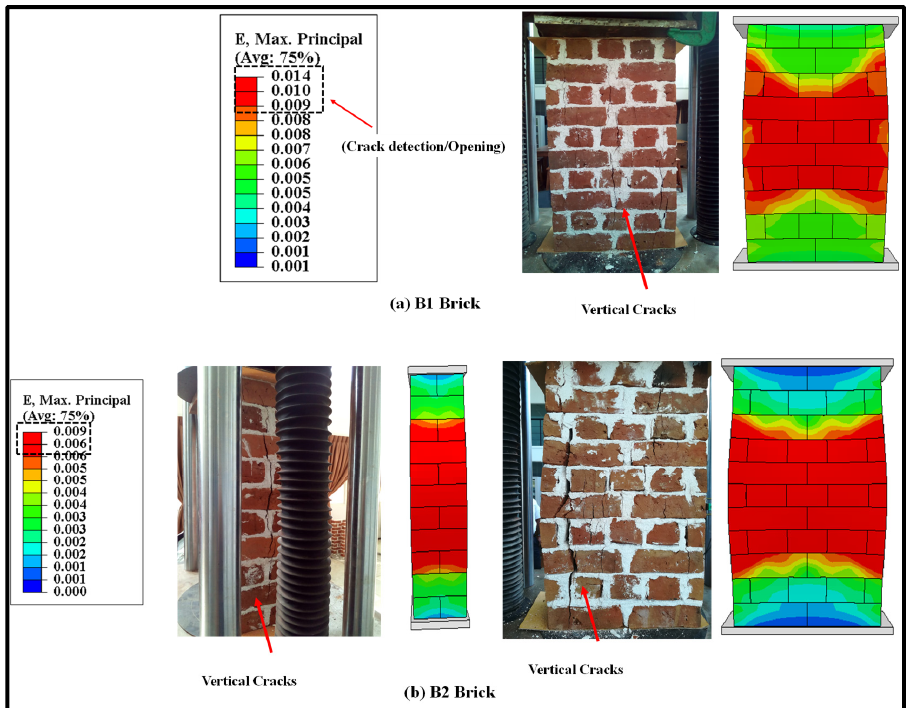
Figure 6. Predicted failure modes of the wallettes compared to the experimental results under monotonic compression test; ( a ) B1 and ( b ) B2 wallettes.